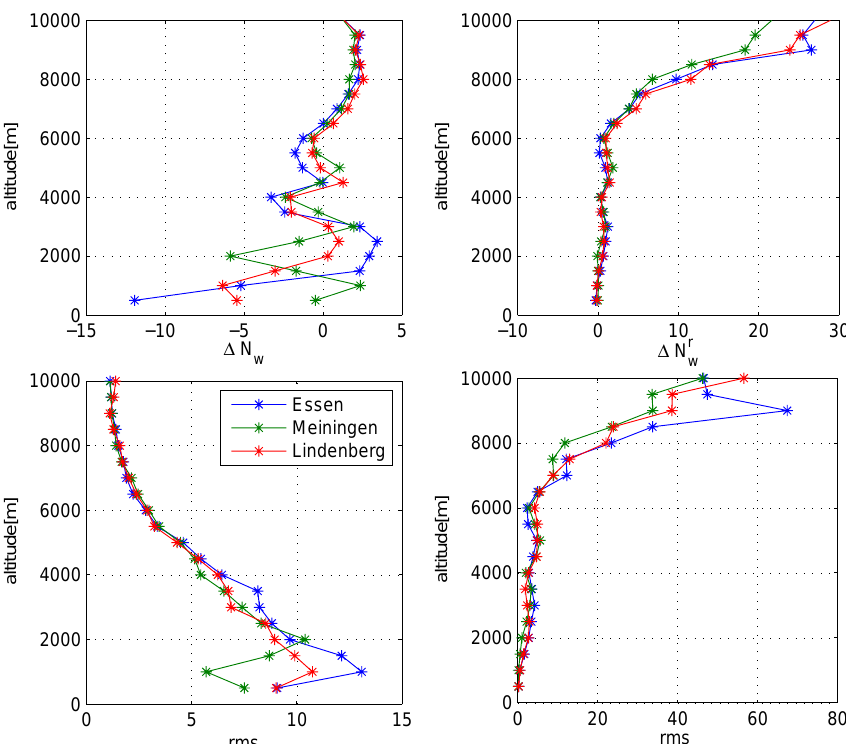
Fig. 8. Mean difference of 1N w and their rms with all (6803) tomography and radiosonde profiles in 20 layers (left panel); relative mean differences of 1N r w and their rms r at the right